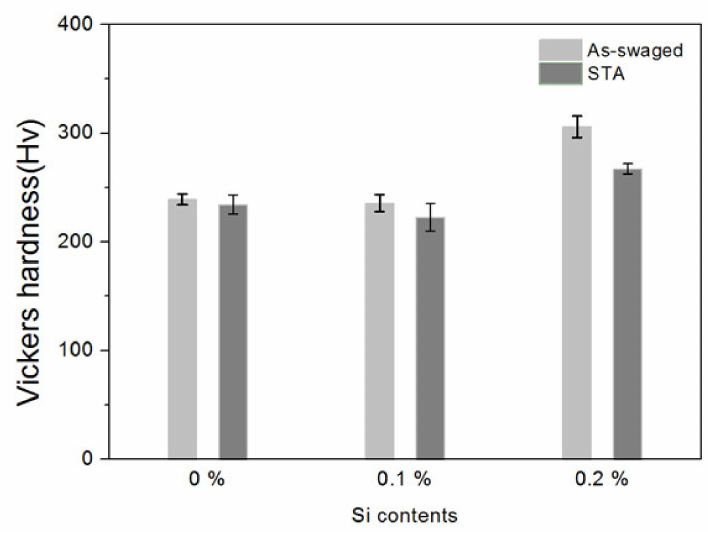
Figure 8. Comparisons of Vickers hardness of TNZ40 + x Si